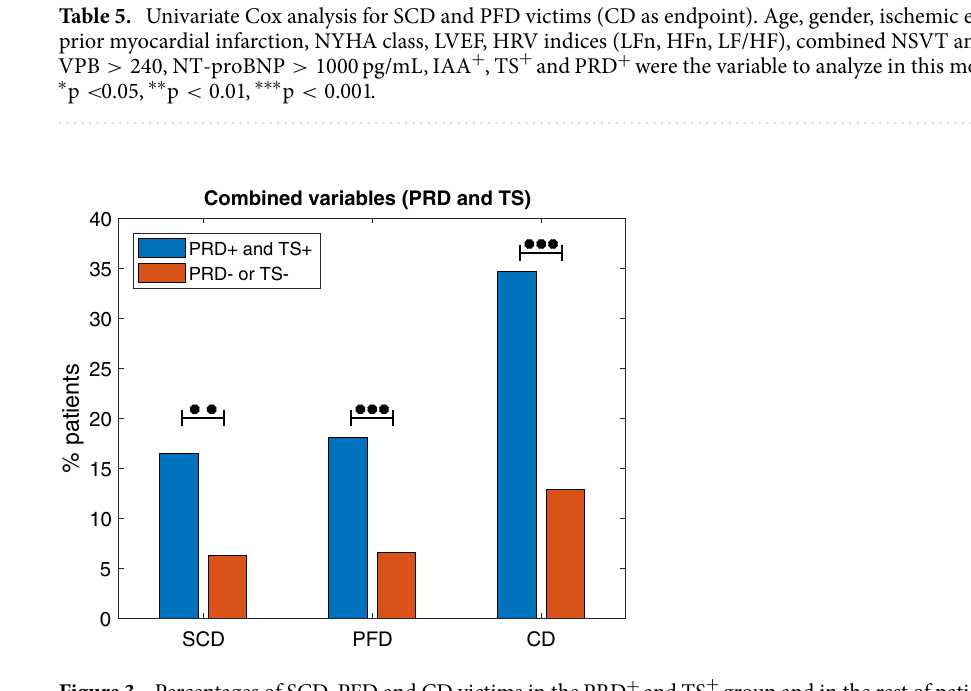
Figure 3. Percentages of SCD, PFD and CD victims in the PRD + and TS + group and in the rest of patients. ∗∗ p < 0.01 , ∗∗∗ p < 0.001